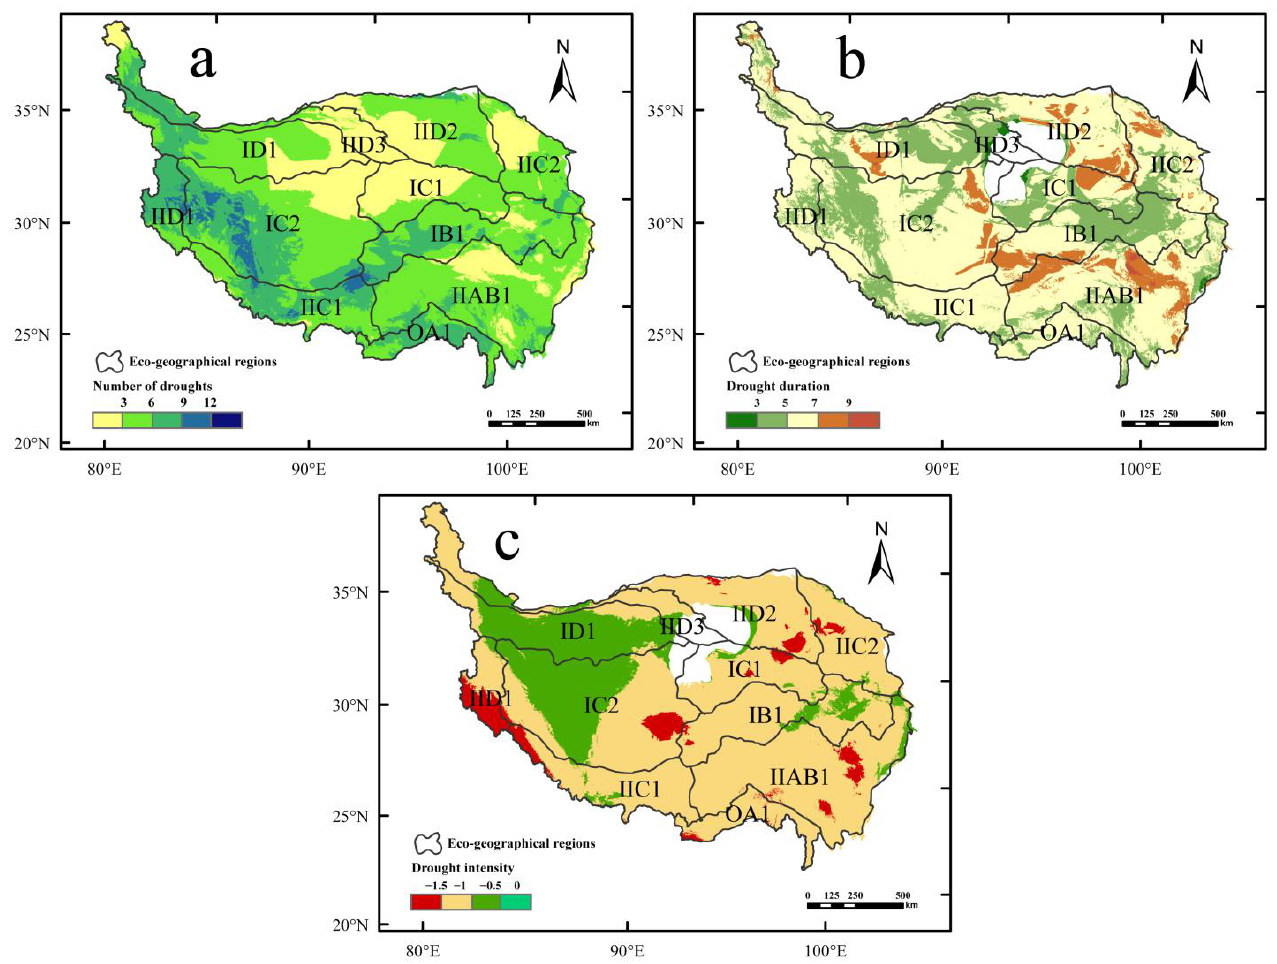
Figure 2. Spatial pattern of drought on the QTP from 2000 to 2018. ( a ) The number of droughts, ( b ) drought duration (month), and ( c ) drought intensity.